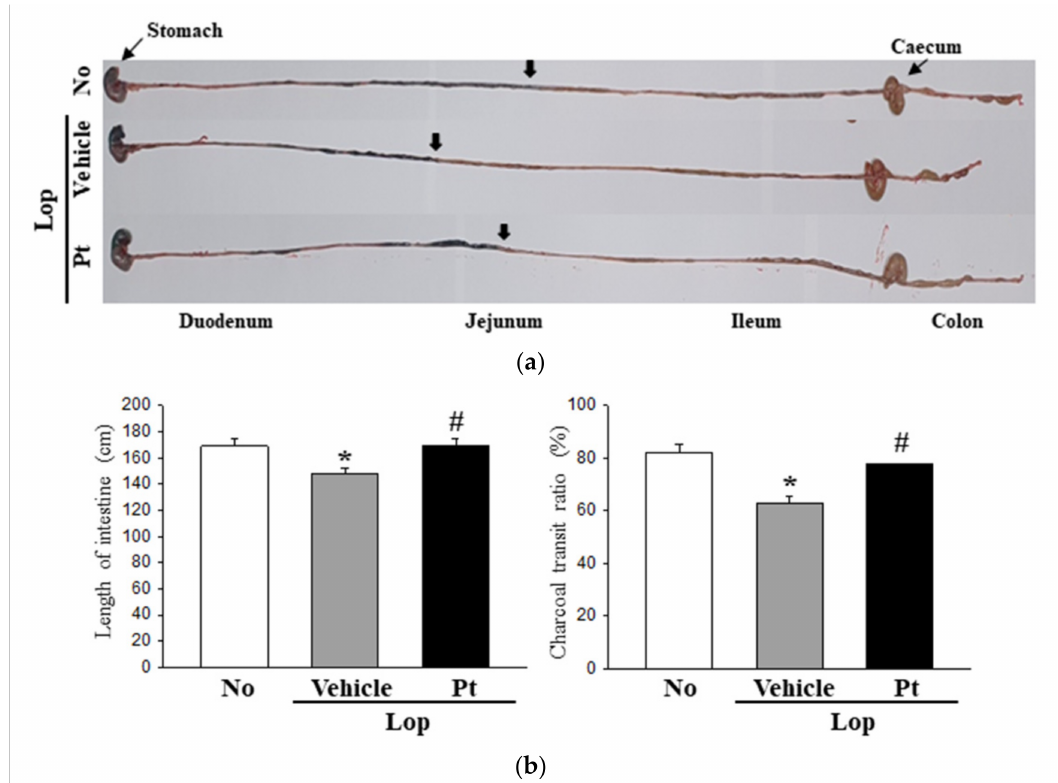
Figure 2. GI transit ratio and intestinal length after administration of Pt. ( a ) Actual digital image of GI. After treatment with charcoal meal powder, the total GI tract from stomach to anus was collected from each rat of subset groups, and their images were taken immediately using a digital camera. The position of charcoal meal transit is indicated with arrows. ( b ) Charcoal transit ratio and length of the intestine. The intestine length in the total GI tract was measured. The transit ratio of the charcoal meal was calculated as the ratio of the distance of the charcoal meal to the total length of the intestine. A total of 8–10 SD rats were used for the GI transit ratio analyses and measurements of intestine length in each group, and each parameter in these analyses was measured in duplicate. The data are reported as the mean ± SD. *, p < 0.05 compared to the non-treated (No) group. #, p < 0.05 compared to the Lop+Vehicle-treated group. Abbreviations: Lop, loperamide; Pt,